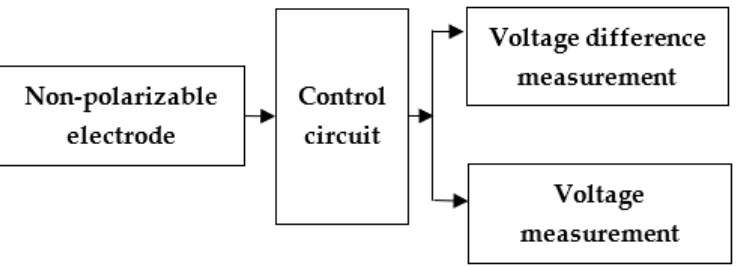
Figure 10. Structures of the voltage and voltage difference measurement circuits.